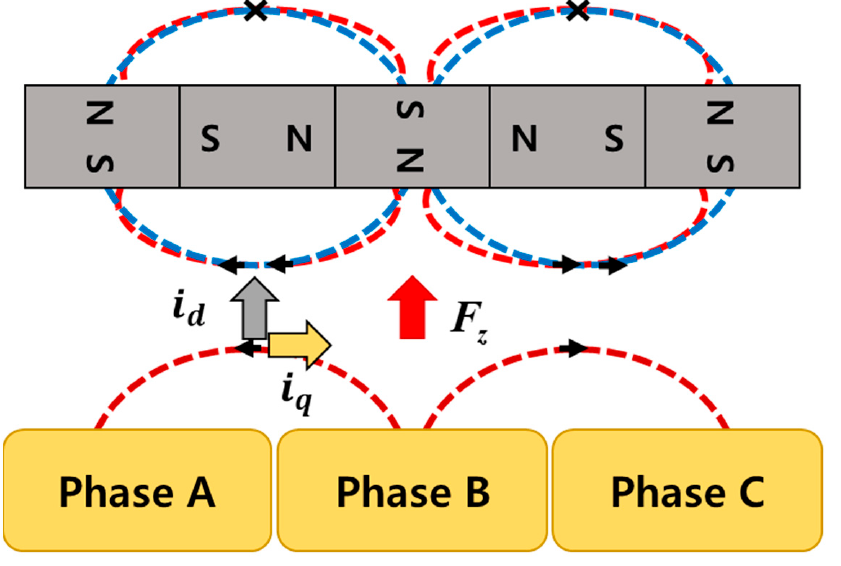
Figure 3. Halbach-array permanent magnet. The control block diagram using the encoder and gap sensor placed in the magnetic levitation system for rotor levitation is shown in Figure 4. First, current is applied through the inverter to generate the levitation force of the system by calculating the error between the levitation position command through each controller corresponding to each part of the stator and the position measured from the position sensor; Equation (2) is the overall levitation command of the system, and Equation (3) is the overall levitation position measured from each gap sensor. levi A , B , C , D * represents the levitation control command of each stator part, and levi pos . A , B , C , D represents the position sensing result of the gap sensor.